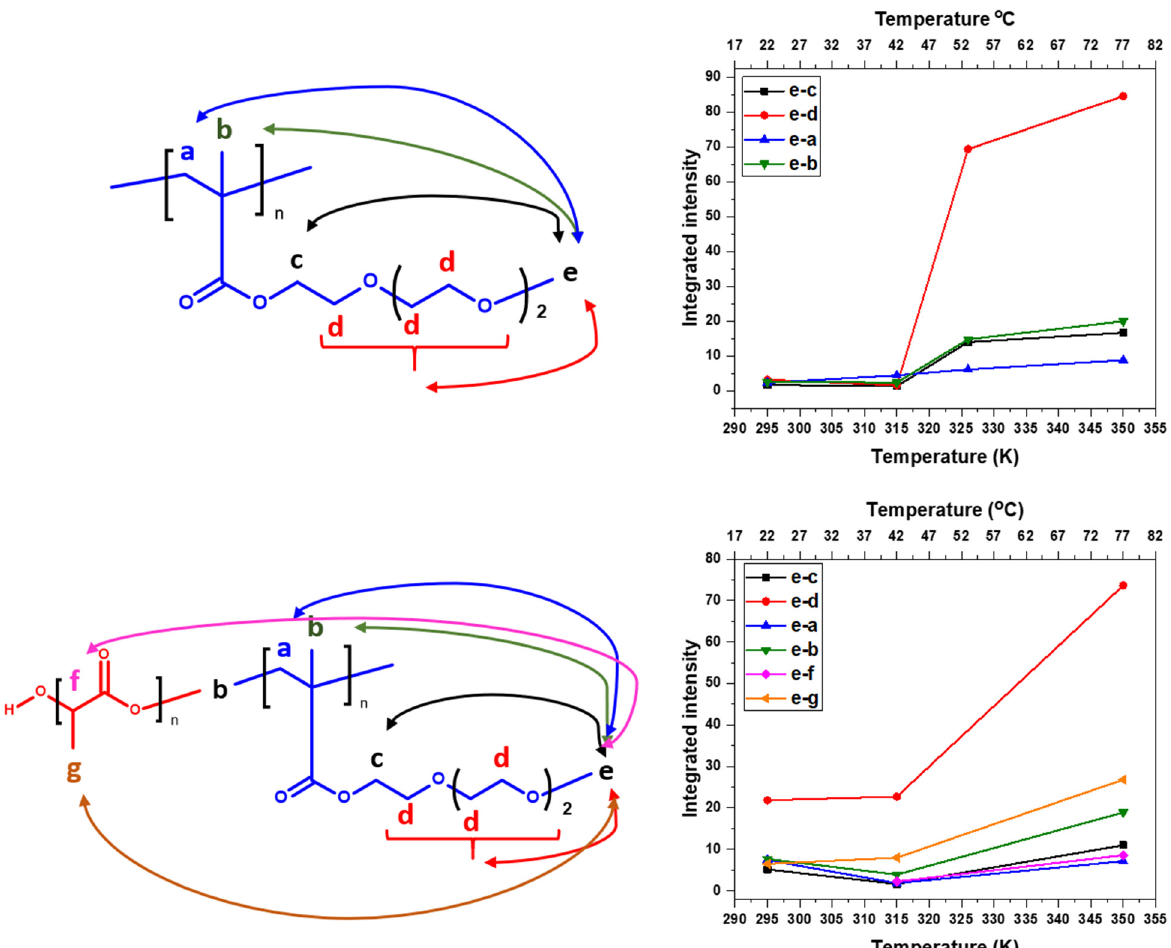
Figure 11. Chemical structures and intermolecular correlations in HP (upper left ) and BC2 ( lower left ). Temperature dependencies of integrated intensities of various signals in 1D slices extracted from the signal of “e” protons of PTEGMA units of the 2D NOESY of D 2 O solutions (c = 2.5 mg·mL − 1 ) of the HP ( upper right ) and BC2 ( lower right ).